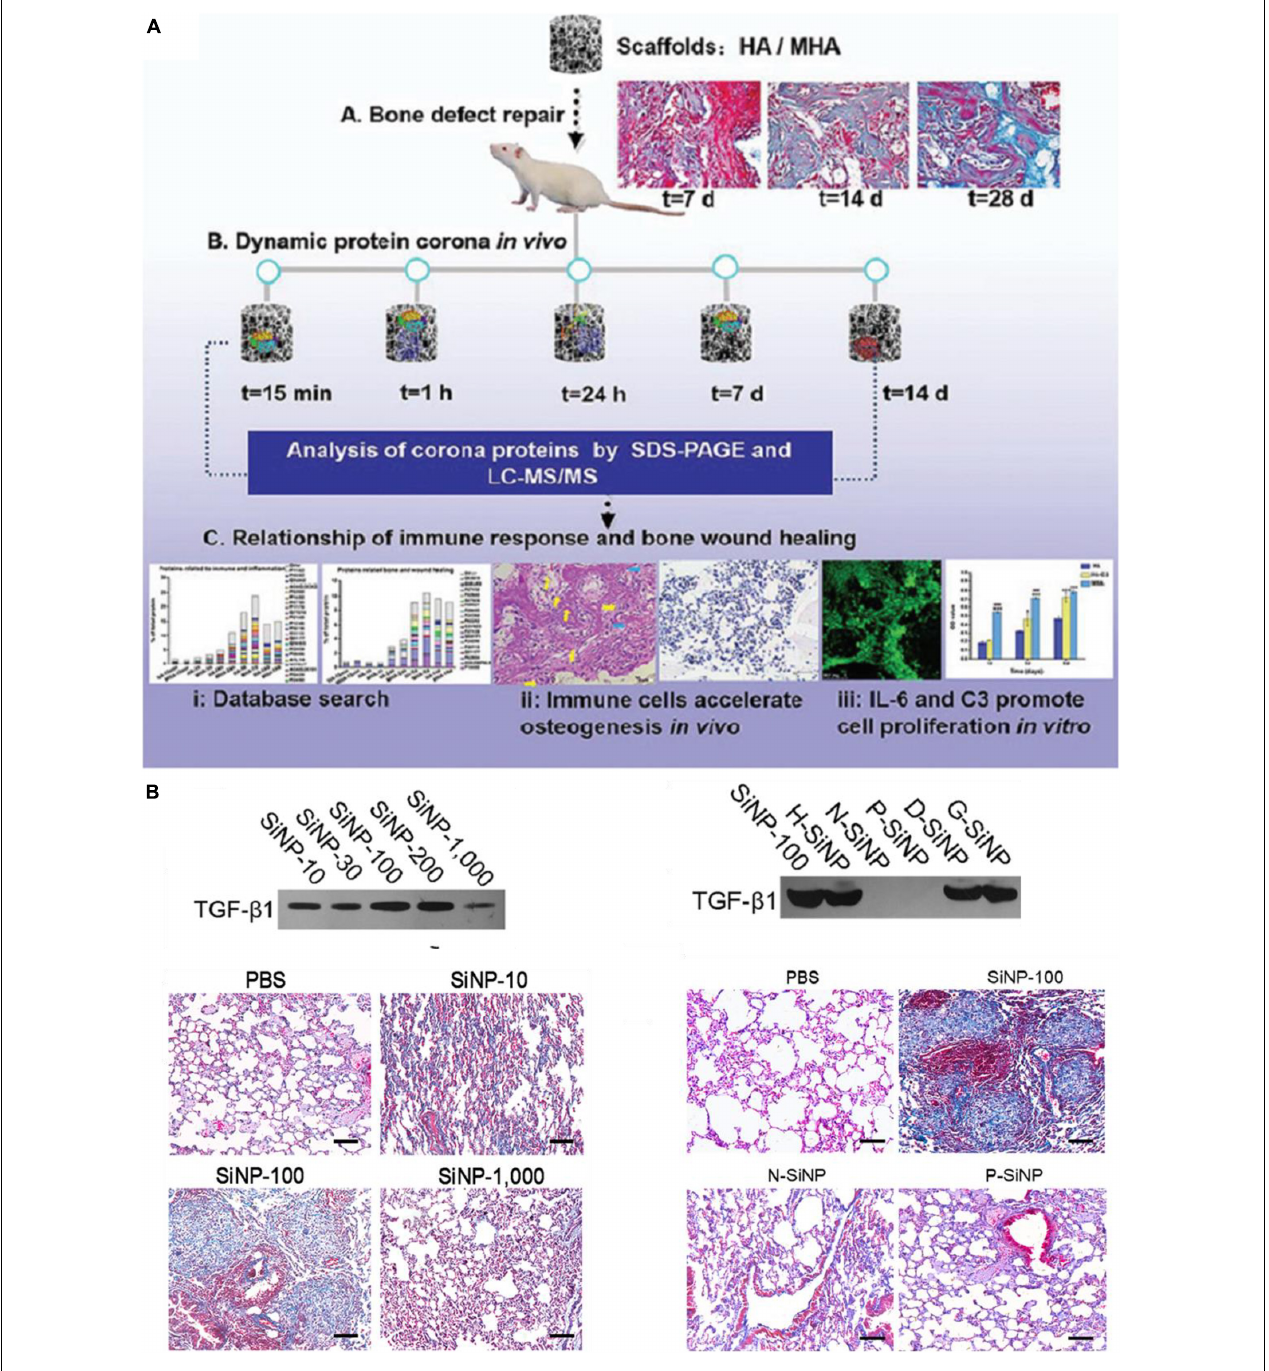
FIGURE 2 | A few examples of PC-induced toxicity. (A) In vivo PC formation influenced immune-modulating osteogenesis by magnetic nanoparticle (MNP)-infiltrated bone regeneration scaffolds. Adapted with permission from Zhu et al. (2019). (B) SiNP-100 specifically recruited TGF- β 1 to their corona and subsequently induced lung fibrosis (N-SiNPs, amination-SiNPs; P-SiNPs, polyetherimide-SiNPs). Adapted with permission from Wang et al. (2017).